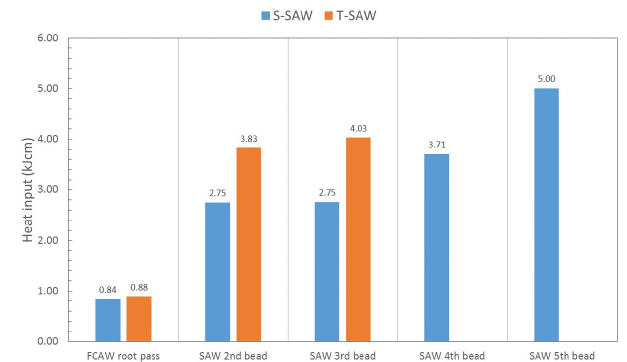
Figure 12: Heat input for each pass in S-SAW and T-SAW experiments.